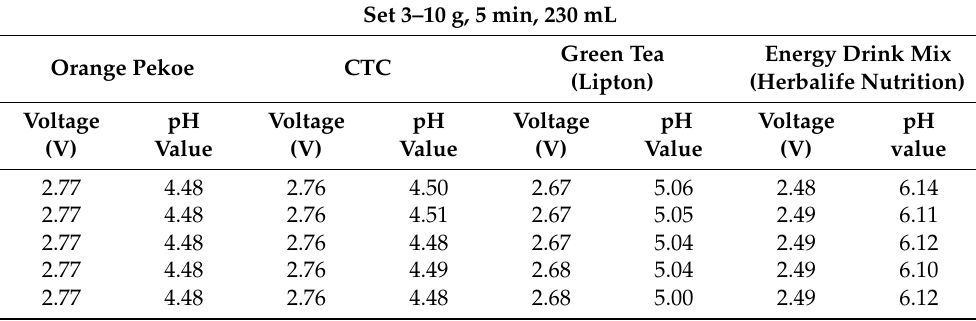
Table 6. pH value and the corresponding port voltage for Set 3–10 g, 5 min, 230